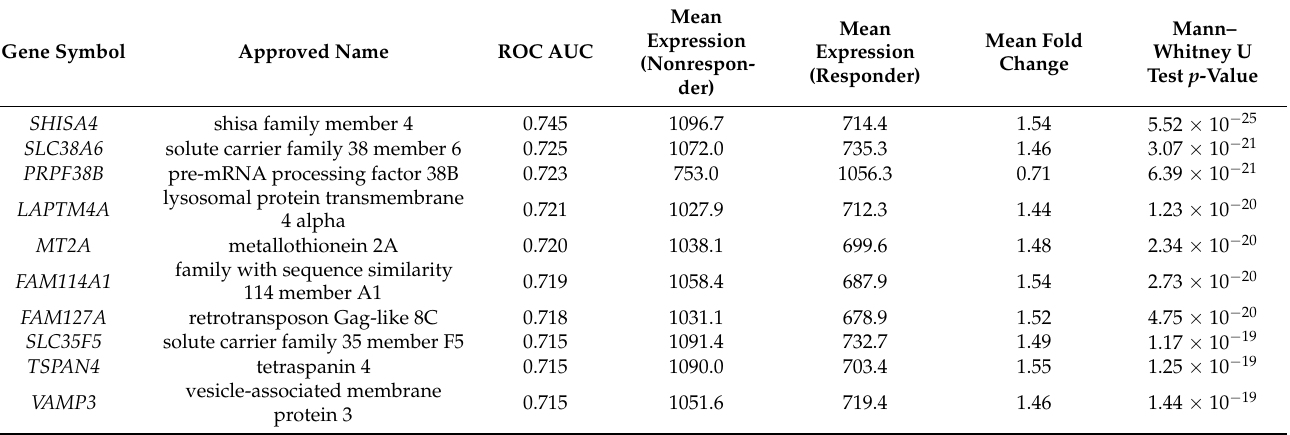
Table 2. The top ten genes associated with response in the fluoropyrimidines treated samples of the in vitro